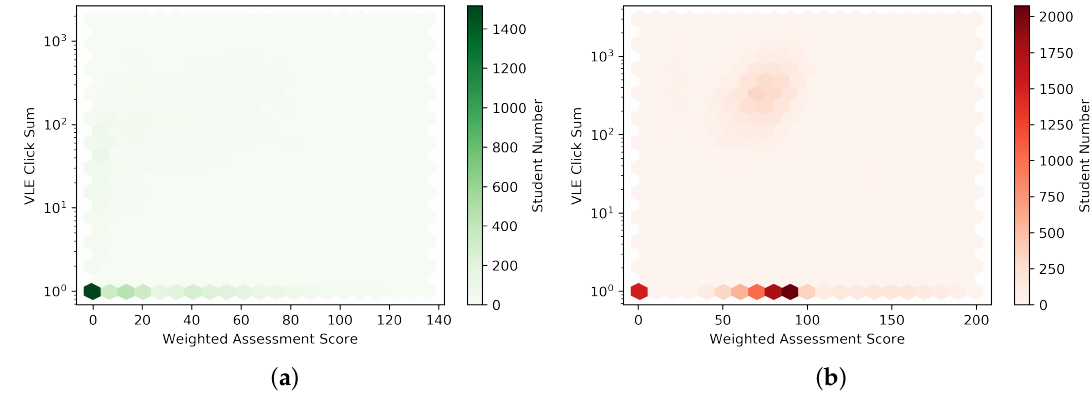
Figure 1. The distribution of virtual learning environment (VLE) click sum and weighted assessment score for students, click sum means the total number of clicks on VLE per students. ( a ): The VLE click sum and weighted assessment score for students who failed the course; ( b ): The VLE click sum and weighted assessment score for students who passed the